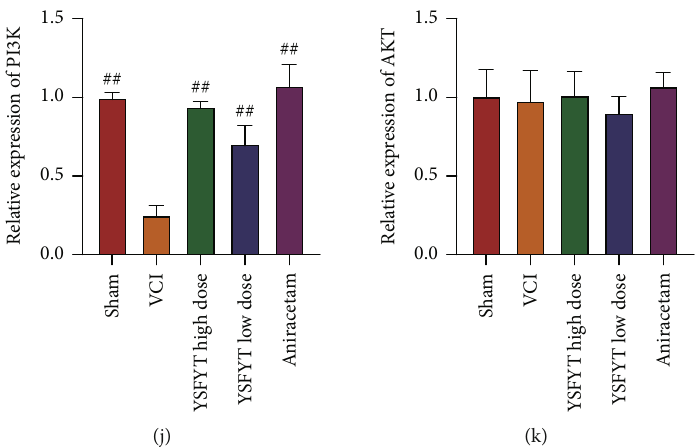
Figure 7: Detection of gene expressions by qPCR. (a – k) The mRNA expression levels of GAP43, MAP-2, SYP, PSD95, NR2B, BDNF, TrkB, MAPK, ERK, PI3K, and AKT. # p < 0 : 05 ; ## p < 0 : 01